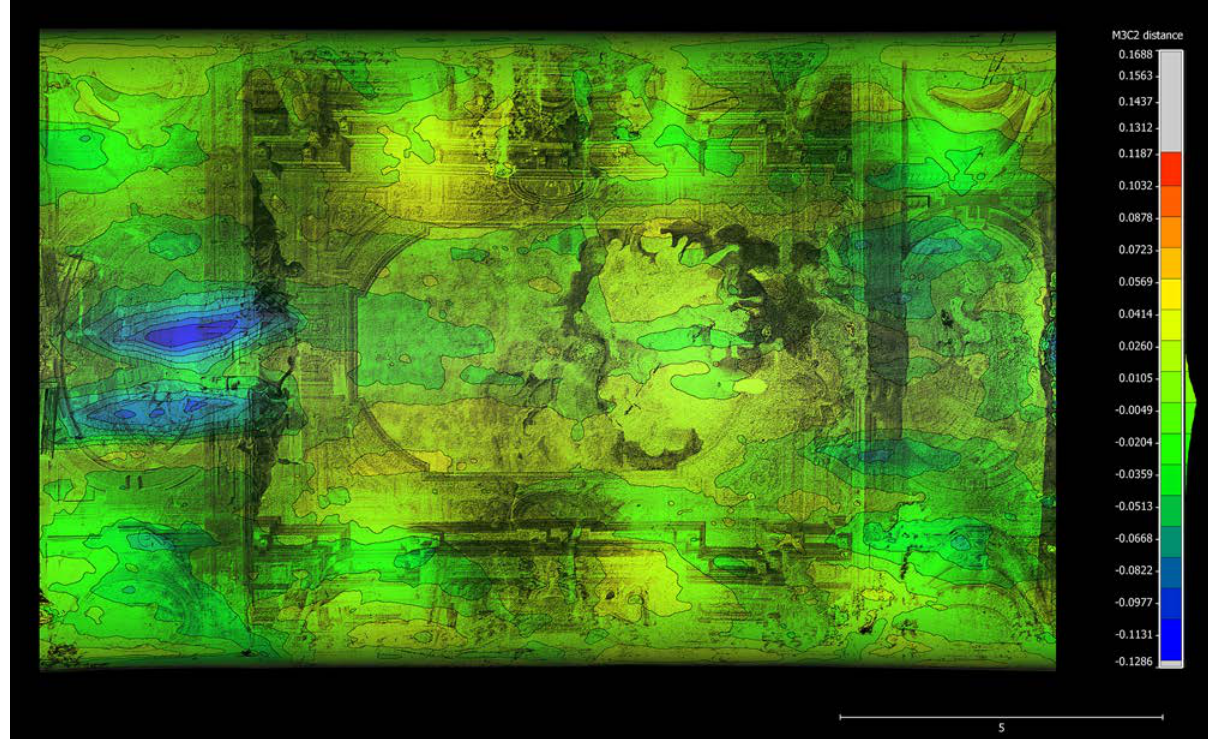
Figure 3. Displacement map between the reference surface and the point model, superimposed on a orthoimage of the